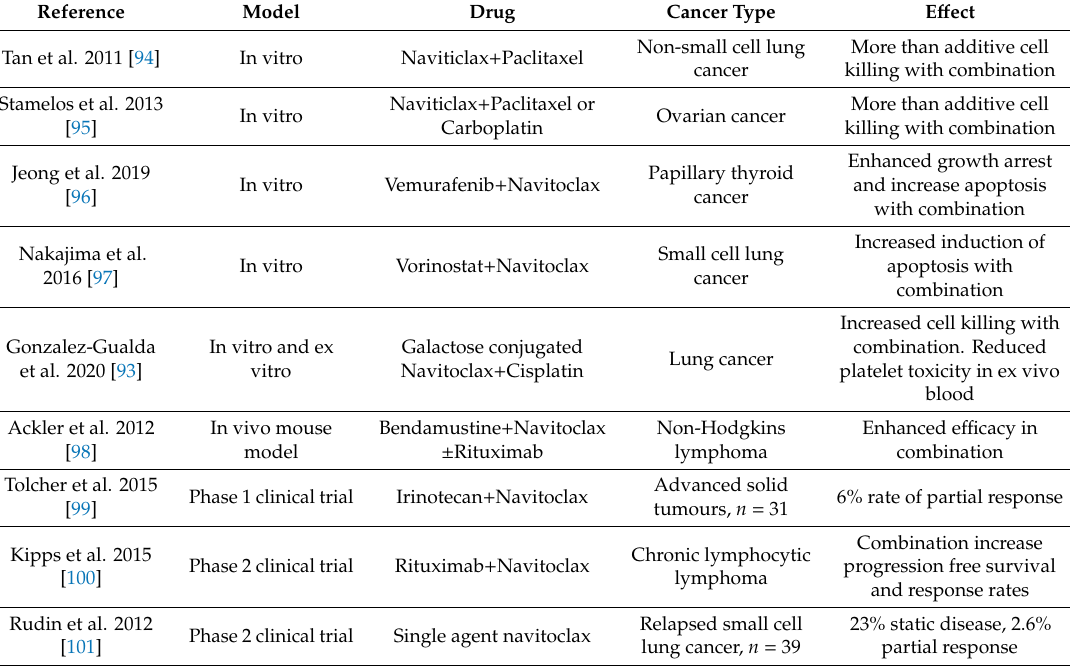
Table 3. Table showing studies of Navitoclax in a range of cancer models and